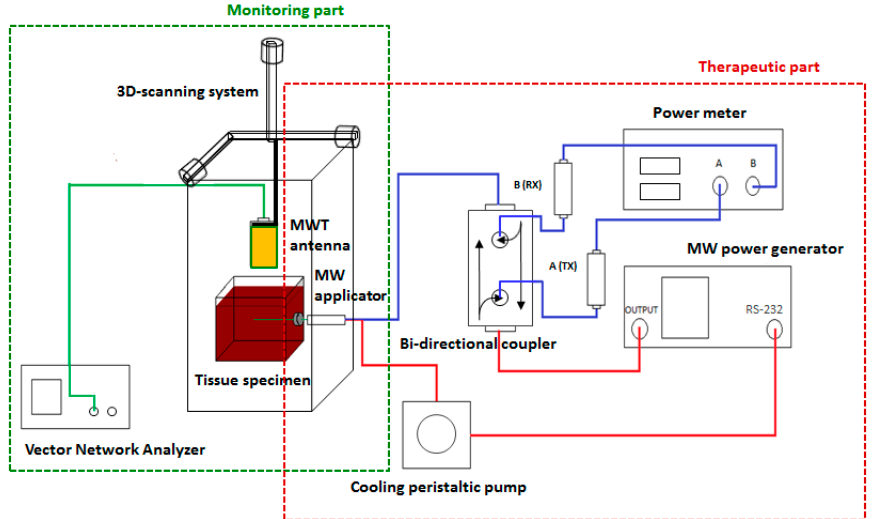
Figure 1. The experimental setup developed for the proof of concept. Tx and Rx denote part of the transmitted signal (Tx) and part of the reflected one (Rx) collected by the directional coupler to measure the actual power fed to the MTA antenna. The green line represents the connection between the vector network analyzed (VNA) and the MWT antenna. The red lines represent the connection of the MW power generator with the bidirectional coupler and with the peristaltic pump, and of the peristaltic pump with the MW applicator. The blue lines represent the connections of the power meter with the bidirectional coupler, and of the bidirectional coupler with the MW applicator. The black arrows refer to conventional symbols used for bidirectional coupler, which identify the directions of propagation of the direct power (forward) and of the reflected power (backward).